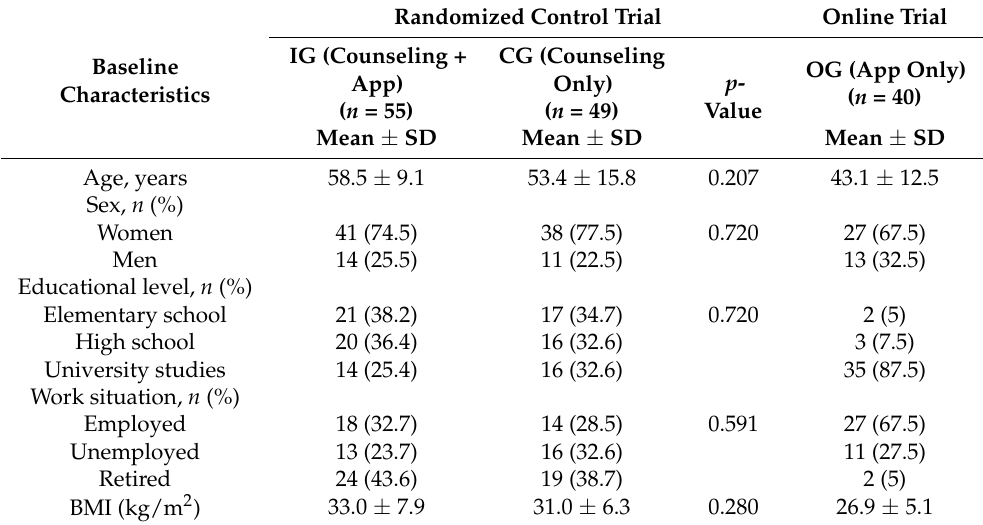
Table 1. Characteristics of the study populations at